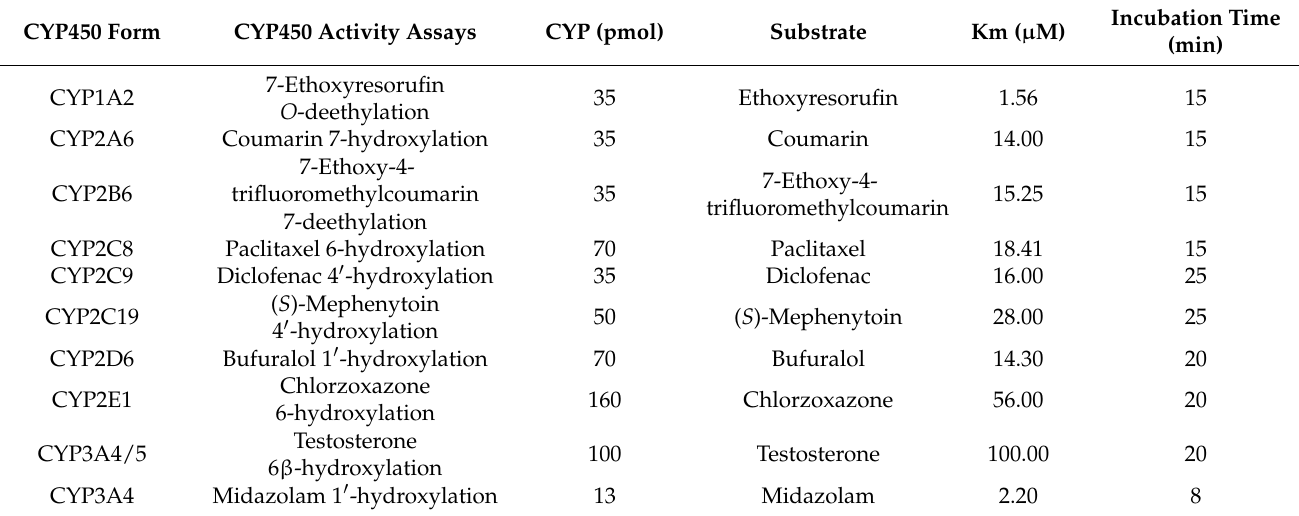
Table 1. Summary of the cytochrome P450 enzyme assay